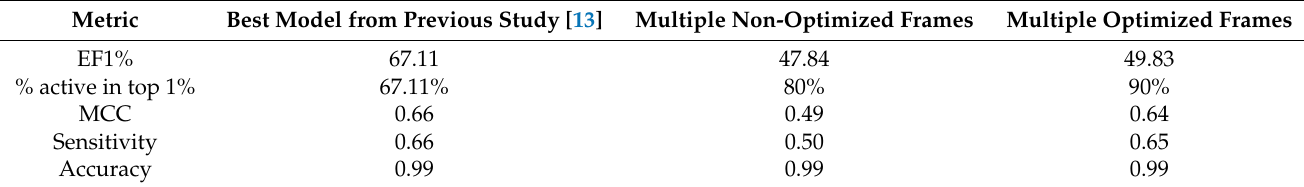
Table 7. Comparison of the here reached performances with that obtained by the best model of the previous study